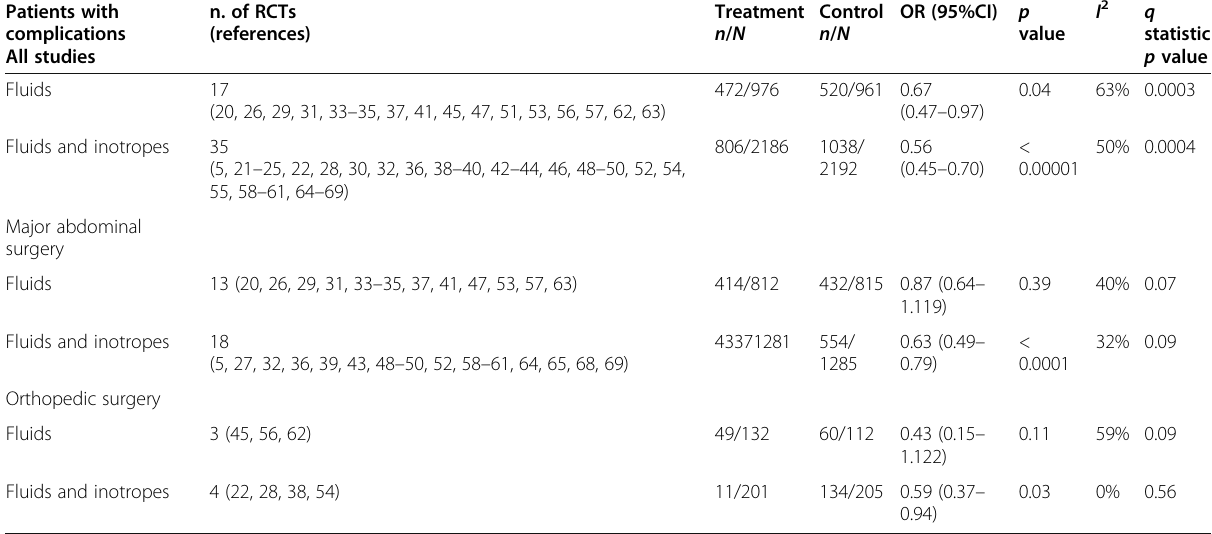
Table 3 The results of the subgroup analyses. RCTs were divided considering the kind of surgery (i.e., major abdominal, orthopedic, vascular, and so on) and on the basis of the strategy adopted (i.e., only fluids or fluids and inotropes) Patients with complications